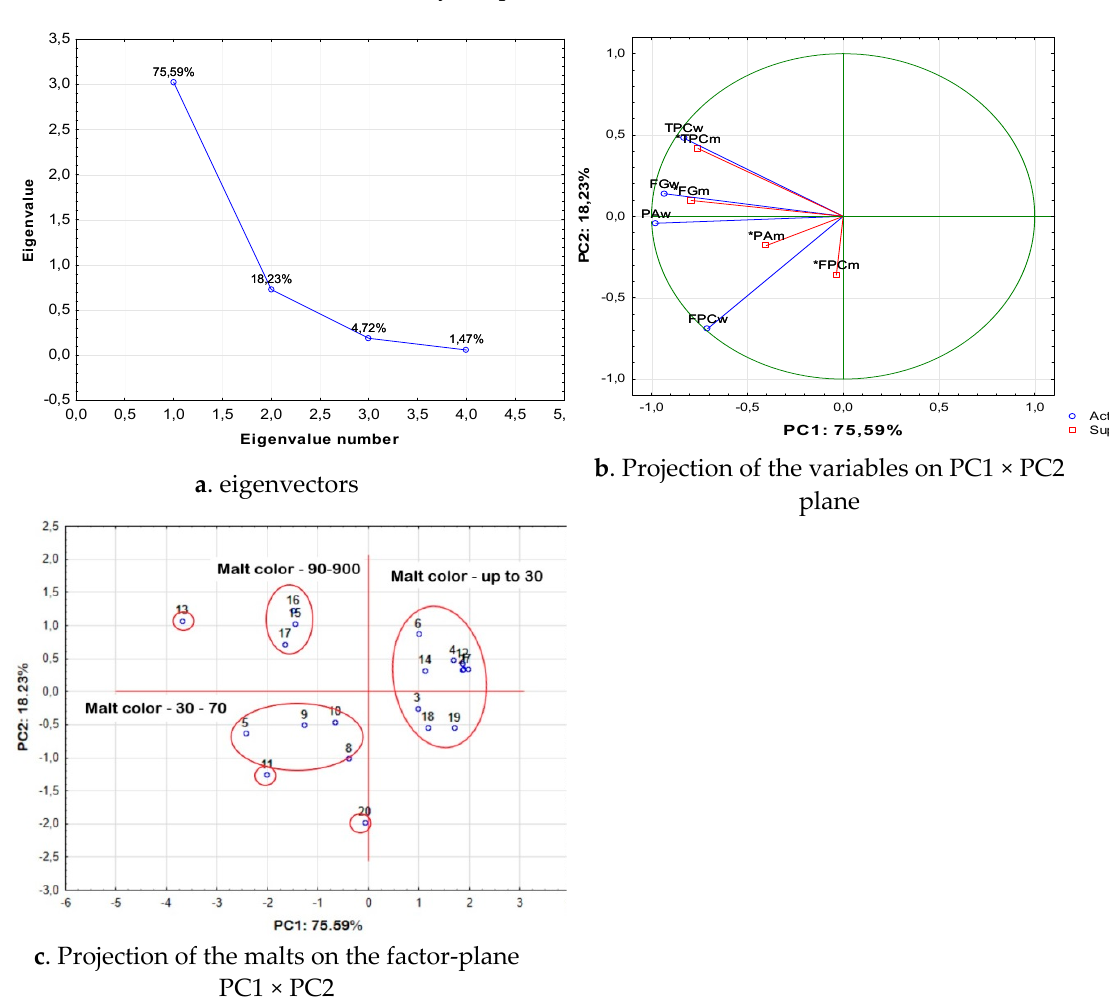
Figure 7. Classification of the malts by the principal components analysis with regard to the content of phenolic compounds. ( a ) eigenvectors; ( b ) Projection of the variables on PC1 × PC2 plane; ( c ) Projection of the malts on the factor-plane PC1 × PC2. 1—Pilsen; 2—Pale ale; 3—Vienna malt; 4—Munich; 5—Melanoidine; 6—Munich dark; 7—Wheat; 8—Red X; 9—Caramel amber; 10—Caramel hell; 11—Black; 12—Caramel pils; 13—Special X; 14—Special Wheat; 15—Caramel Munich I; 16— Caramel Munich II; 17—Chocolate; 18—Rye; 19—Acidulated; 20—Smoked malt. Legend: “,”—decimal point; “-”—minus sign; *—denotes the supplement variable during